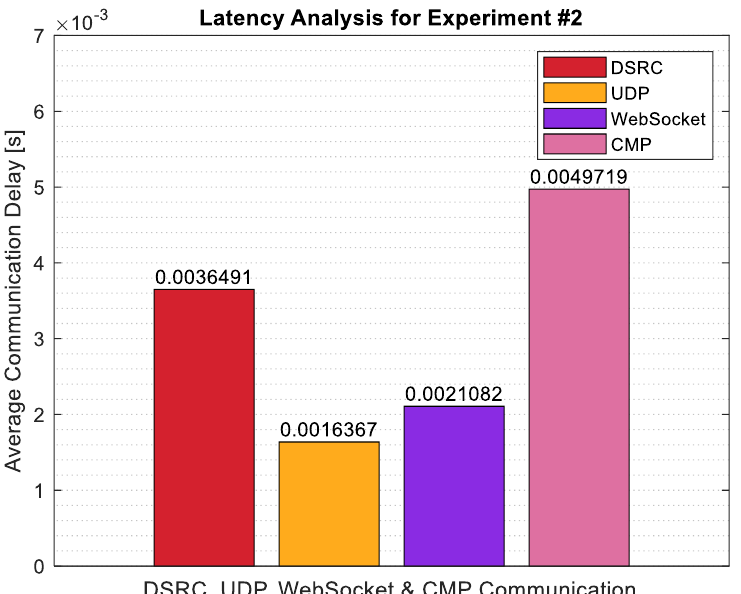
Figure 12. Latency analysis for Experiment #2.